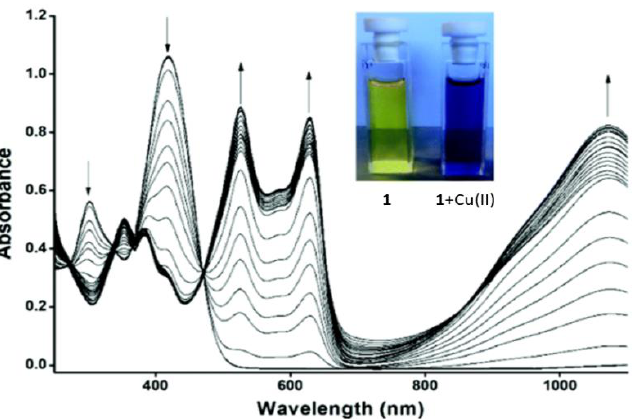
Figure 2. Spectrophotometric titration of compound 1 (5.0 × 10 −5 mol L −1 ) upon addition of increasing amounts of Cu(II) (from 0 to 10 eq.) in acetonitrile, and respective color changes (adapted